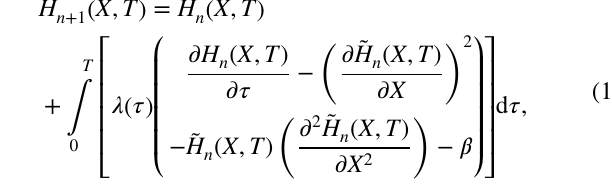
Fig. 1 Graphic representation of an unconfined aquifer with horizon- tal impermeable